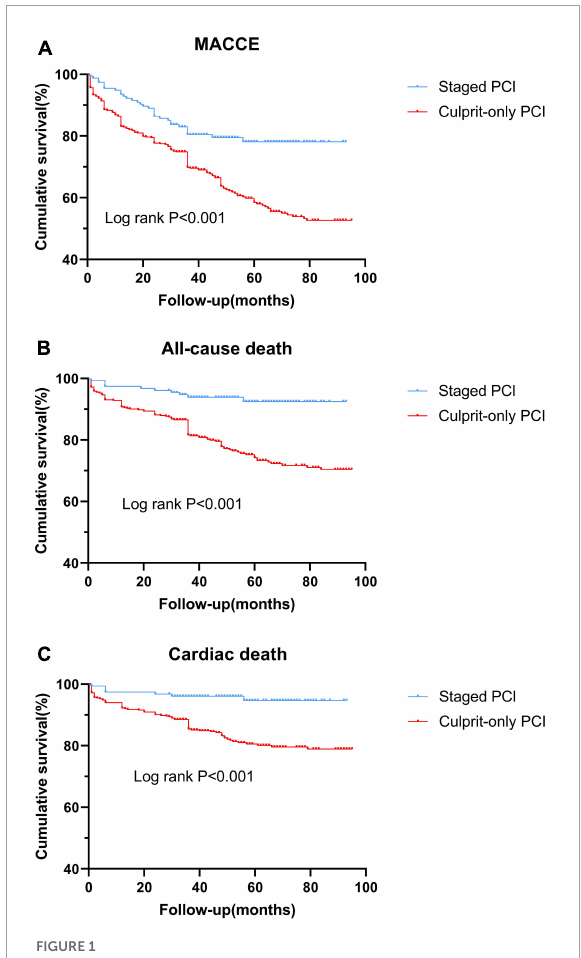
FIGURE1 Kaplan-Meier curves of clinical outcomes in the two groups before the propensity score matching analysis. (A) MACCE; (B) all-cause death; and (C) cardiac death. MACCE, major adverse cardiac and cerebrovascular event; PCI, percutaneous coronary